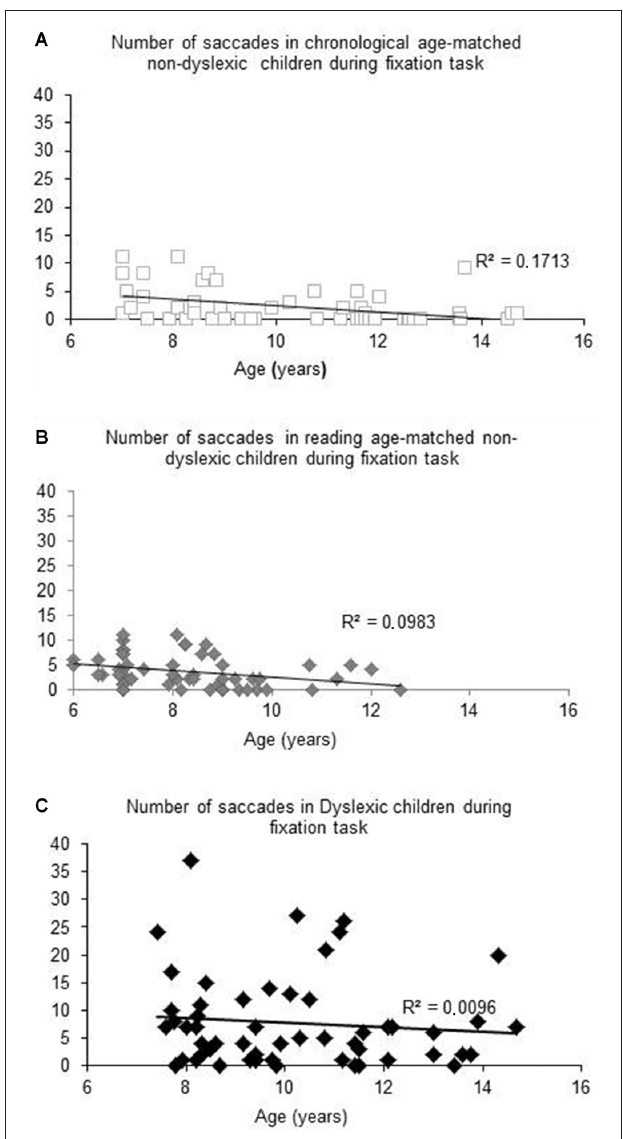
FIGURE 1 | Number of saccades measured during fixation task for Chronological age-matched non-dyslexic children (A), reading age-matched non-dyslexic children (B) and dyslexic children (C). Line represents the corresponding regression.